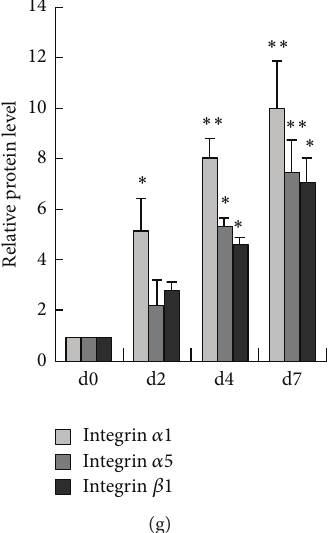
Figure 1: VEGF induces angiogenesis and high integrin expression in differentiated MSCs. (a) DiI-Ac-LDL uptake assay in differentiated MSCs. Parallel experiments in HUVECs served as a positive control. (b) Percentages of MSCs that incorporated DiI-Ac-LDL were calculated, and the data were expressed as percentages compared with the overall cell count. ∗∗ 𝑃 < 0.01 , 𝑛 = 3 . (c) MSCs seeded onto a basement membrane-like gel were treated with VEGF for 4, 7, and 14 days. VEGF-free MSCs were seeded onto a basement membrane-like gel for 7 days (Control group). (d) Capillary-like structures were quantified by measuring the polygonal network. (e) After MSCs were cultured in EC differentiation medium for 7d, integrins 𝛼 1, 𝛼 5, and 𝛽 1 were examined by qPCR. ∗ 𝑃 < 0.05 ; ∗∗ 𝑃 < 0.01 , 𝑛 = 3 . (f) Western blotting assay for integrins 𝛼 1, 𝛼 5, and 𝛽 1. (g) The relative quantification of the protein expression was statistically analyzed using Image J software. ∗ 𝑃 < 0.05 ; ∗∗ 𝑃 < 0.01 , 𝑛 = 3